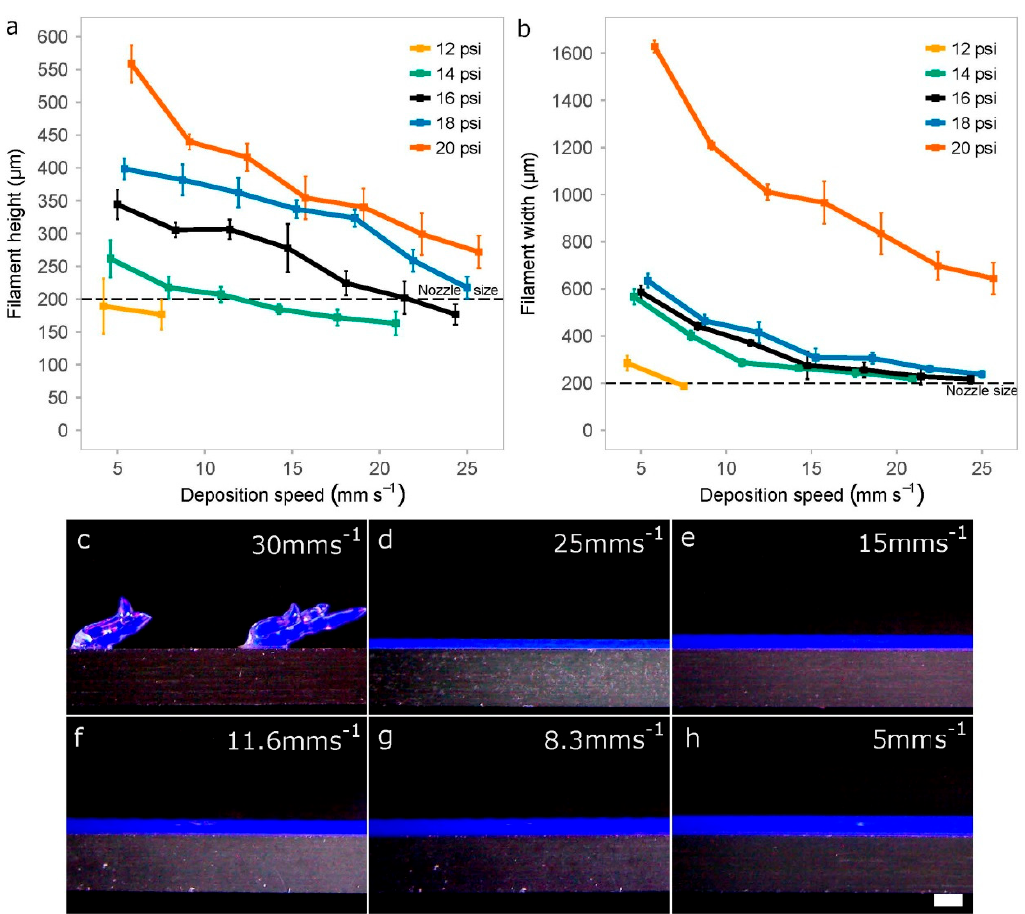
Figure 9. Impact of the printing pressure and deposition speed when creating rectilinear filaments. Quantification of the height ( a ) and width ( b ) of the printed filaments using 40 wt % P407 and a 27G tapered nozzle. Data represents the mean and standard deviation of six different samples ( n = 6);